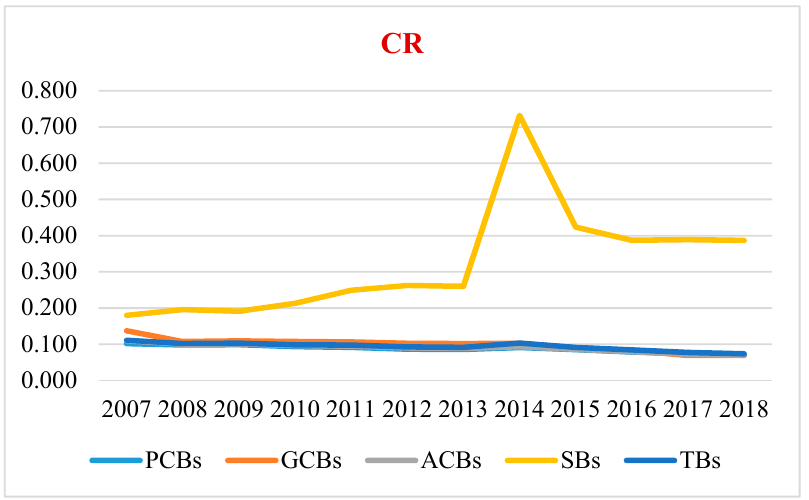
Figure 1. Comparative trends of the Capital Ratio (CR) (during the study period of 2007–2018). J. Risk Financial Manag. 2020 , 13 , x FOR PEER REVIEW